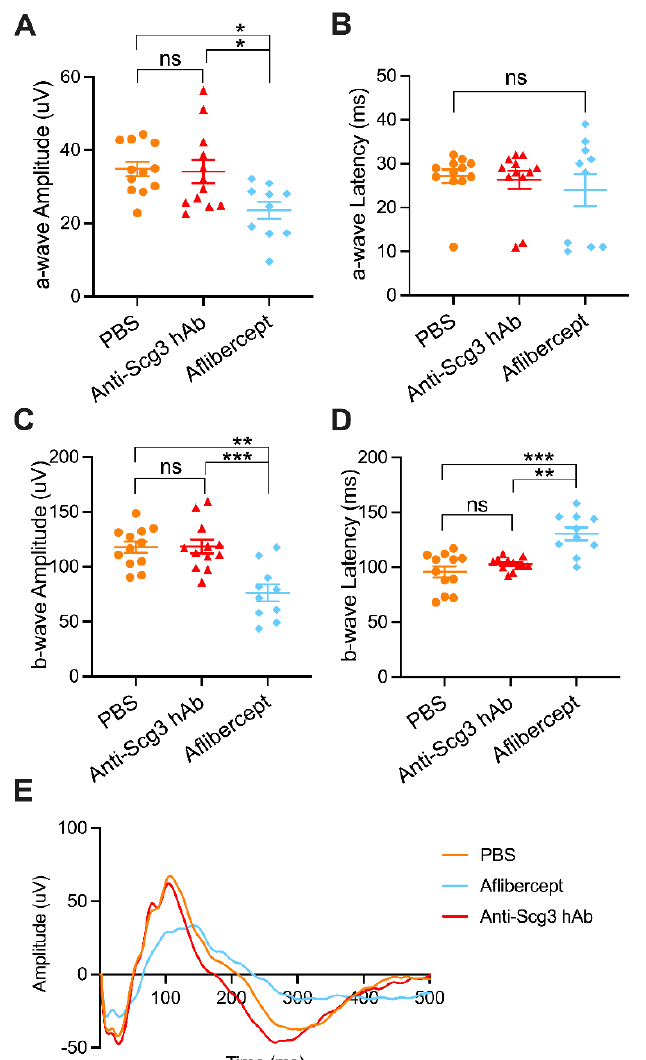
Figure 5. Systemic treatment with anti-Scg3 hAb does not adversely affect visual function in healthy neonatal mice. ( A – E ) Short-term pfERG of healthy mice at P21 (i.p. treatment began at P7, followed by continually i.p. injection every other day until P19) detected no change in a-wave amplitude and latency ( A , B ) as well as b-wave amplitude and latency ( C , D ) with anti-Scg3 hAb. Aflibercept therapy demonstrated a decrease in all parameters except in the latency of a-wave. Average ERG graphs of all mice in each group were depicted in ( E ). Mean ± SEM. n = 12 eyes (PBS), 10 eyes (aflibercept) and 12 eyes (anti-Scg3 hAb). * p < 0.05, ** p < 0.01, *** p < 0.001; ns, not significant; one-way ANOVA test.